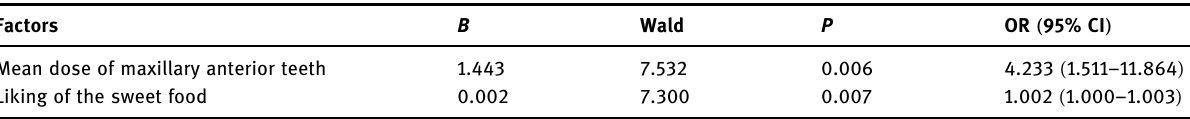
Table 2: Multi - factor analysis results a ff ecting GOHAI Factors Mean dose of maxillary anterior